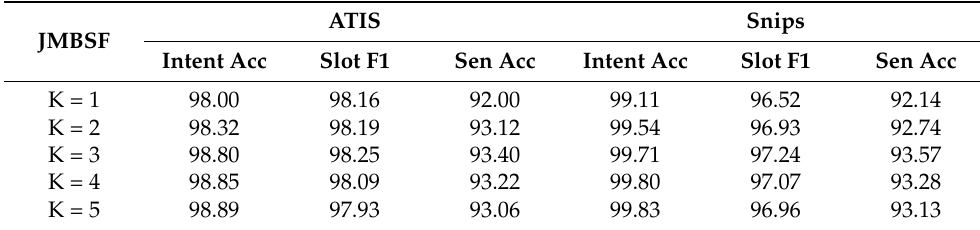
Table 5. Comparison of K-value ablation studies in feature fusion